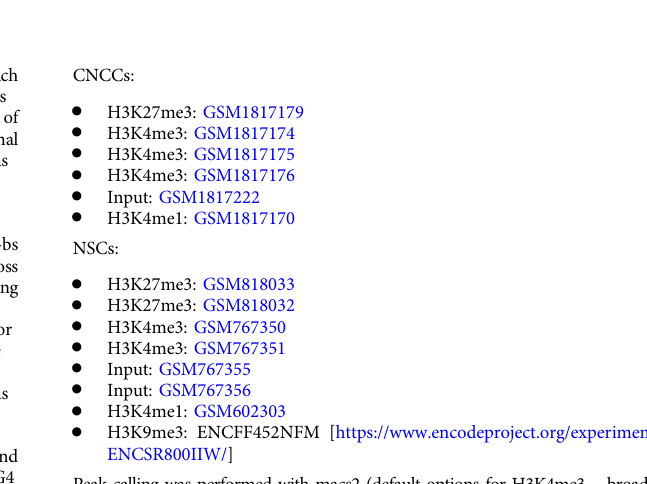
Fig. 6 G4 structure stabilisation delays hESC differentiation. a Schematic of G4-ligand treatment experiment: OCT4-EGFP expressing hESCs were differentiated into CNCCs using a 2-day pulse using GSK3 β (CHIR99021) and ROCK inhibition (Y-27632) 59 . Samples were taken at the indicated times to determine the percentage of cells positive for the pluripotency marker OCT4 (by fl ow cytometry and immuno fl uorescence microscopy (IF)) or SOX10 (by IF; lineage marker for CNCC) or RNA-seq. Insert chemical structure of the G4-speci fi c ligand PhenDC3. b – d Proportion of b OCT4 and d SOX10 positive cells determined in IF studies. N = 52 fi elds of view per sample. One biological replicate (see Source Data for detailed cell counts). *: p < 0.05, one-sided Pearson ’ s χ 2 test for proportions (see Source Data for exact p-values and number of cells analysed). See Supplementary Fig. 17 for additional biological replicates. c Representative confocal IF images of differentiating OCT4-EGFP hESCs treated with either DMSO or PhenDC3. SOX10 = red, OCT4 = green and DAPI (nuclear stain) = blue. Scale bar = 100 μ m. e Heatmap showing gene expression (Log10 median gene expression (TPM + 0.1)) of the indicated pluripotency and cranial neural crest genes in hESCs and hESCs treated with cranial neural crest induction media alone (Control) or with DMSO or 2 μ M PhenDC3 at 3 and 5 days of differentiation. f Schematic of the main fi ndings of our study: G4 abundance correlates with stem cell plasticity (top left); G4 presence is associated with particular promoter histone landscapes in differentiation (top right); and maintenance of a promoter G4 from hESCs to differentiated daughter cells preserves the transcriptional output of a gene independent of transcription